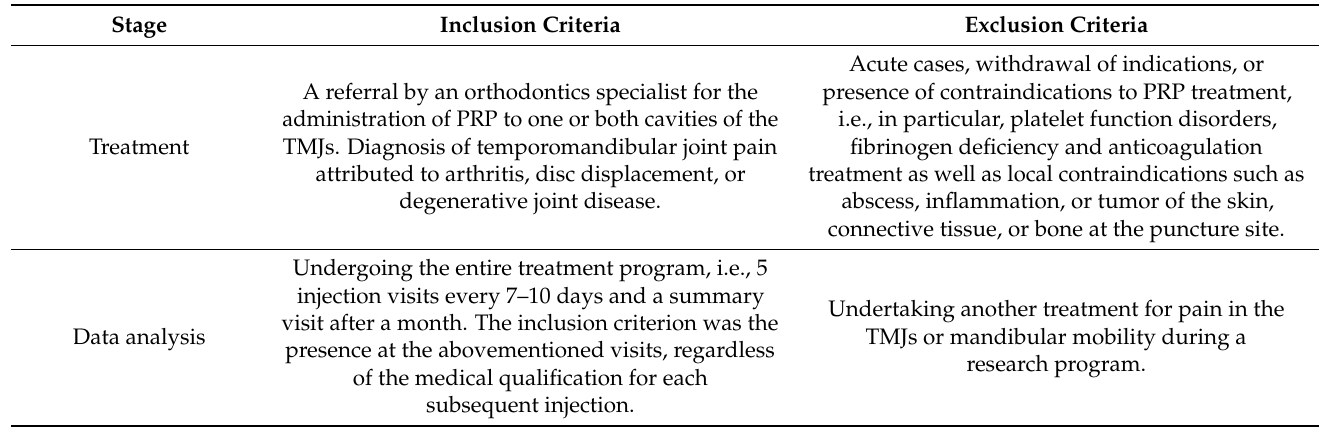
Table 1. Inclusion and exclusion criteria for the research